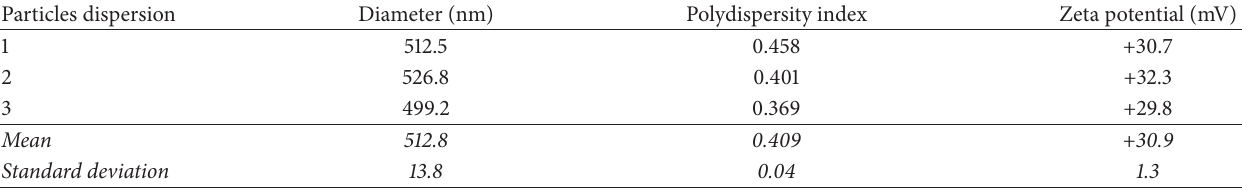
Table 1: Values of diameter, polydispersity index, and zeta potential of three dispersions of enoxaparin